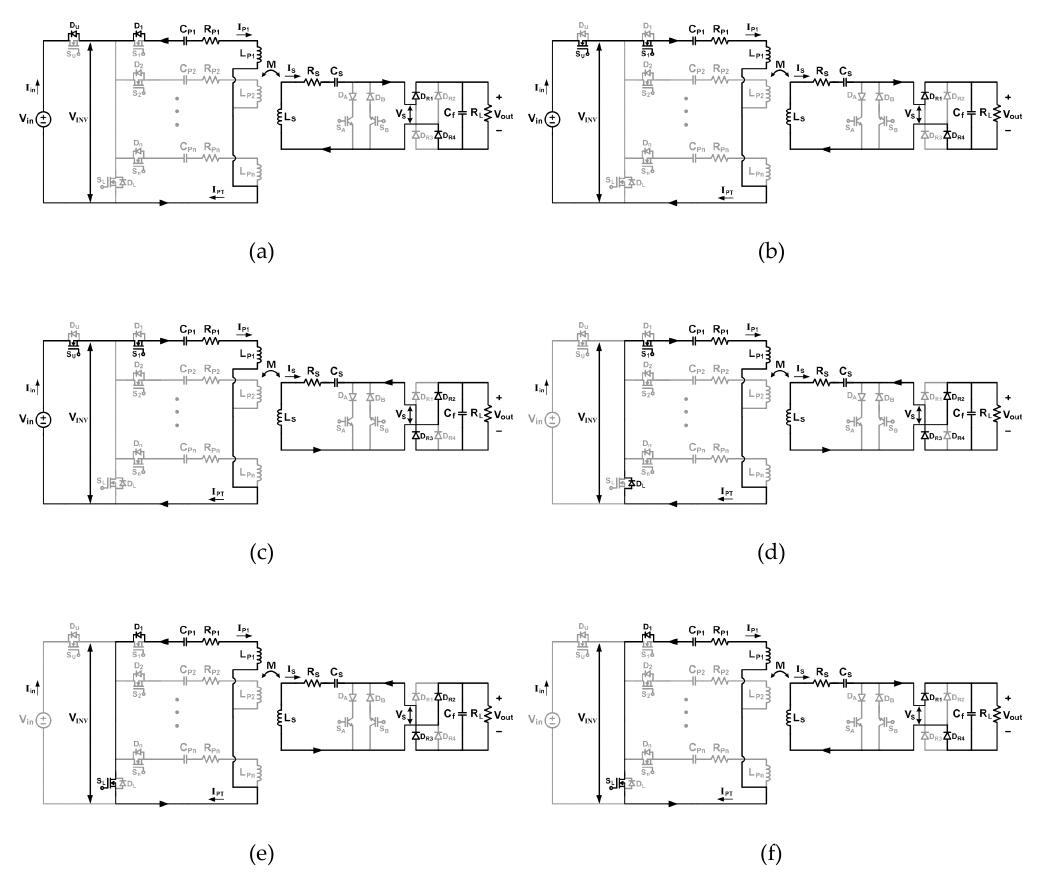
Figure 4. Switching operation of the normal mode: ( a ) Stage 1 [t a –t b ]; ( b ) Stage 2 [t b –t b’ ]; ( c ) Stage